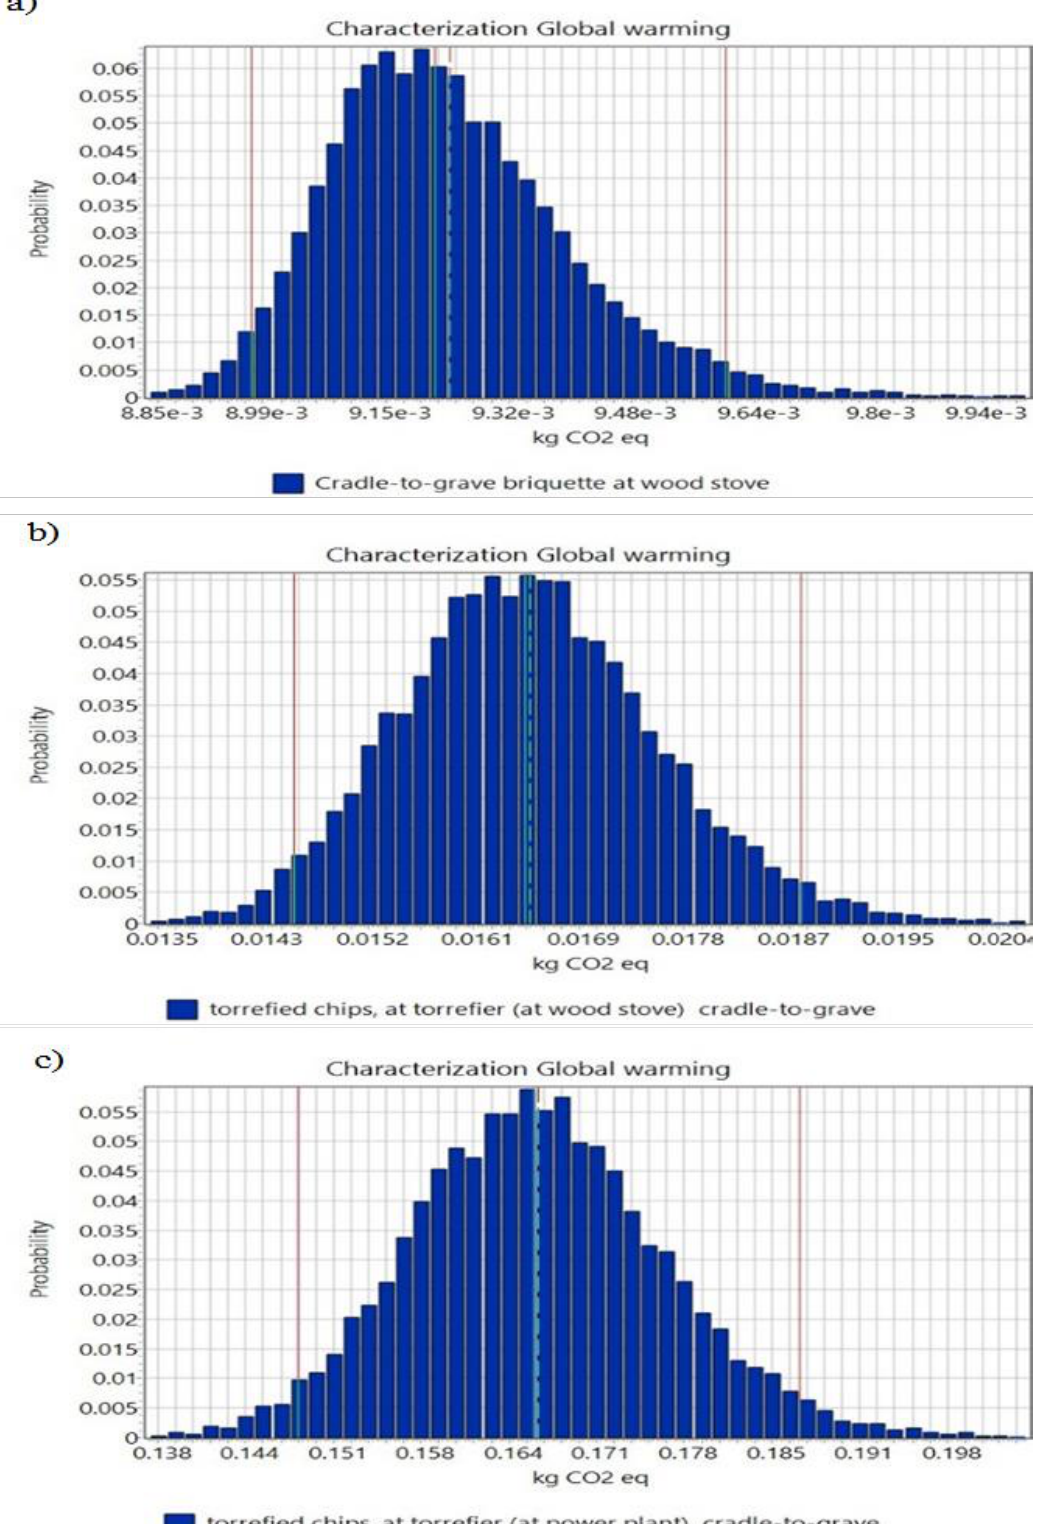
Figure 9. Probability distribution of GW impact for heat from ( a ) wood briquettes, and ( b ) torrefied wood briquettes (TWBs), and ( c ) electricity production from TWBs. Torrefied wood briquette scenarios showed a slightly higher coefficient of variation. The 95% confidence interval for 𝑇𝑊𝐵 𝑒𝑙𝑒𝑐𝑡𝑟𝑖𝑐𝑖𝑡𝑦 was between 148 and 187 gCO 2 eq. Key